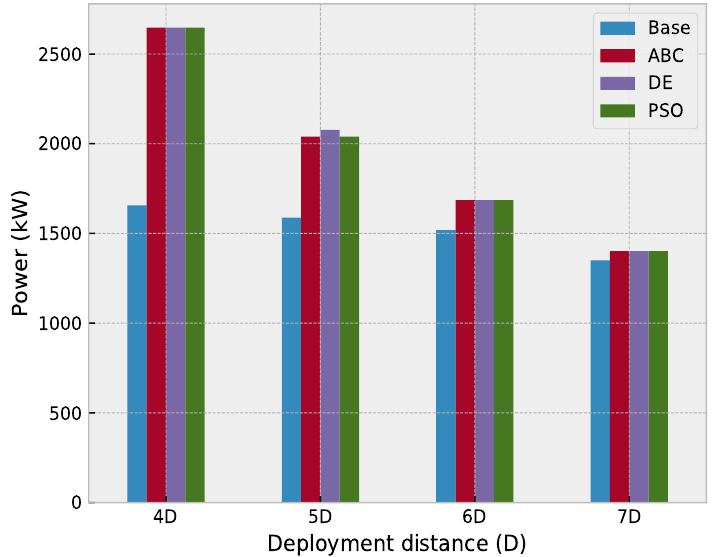
Figure 11. Total plant power for all deployment distances, at 7 m/s mean wind speed.